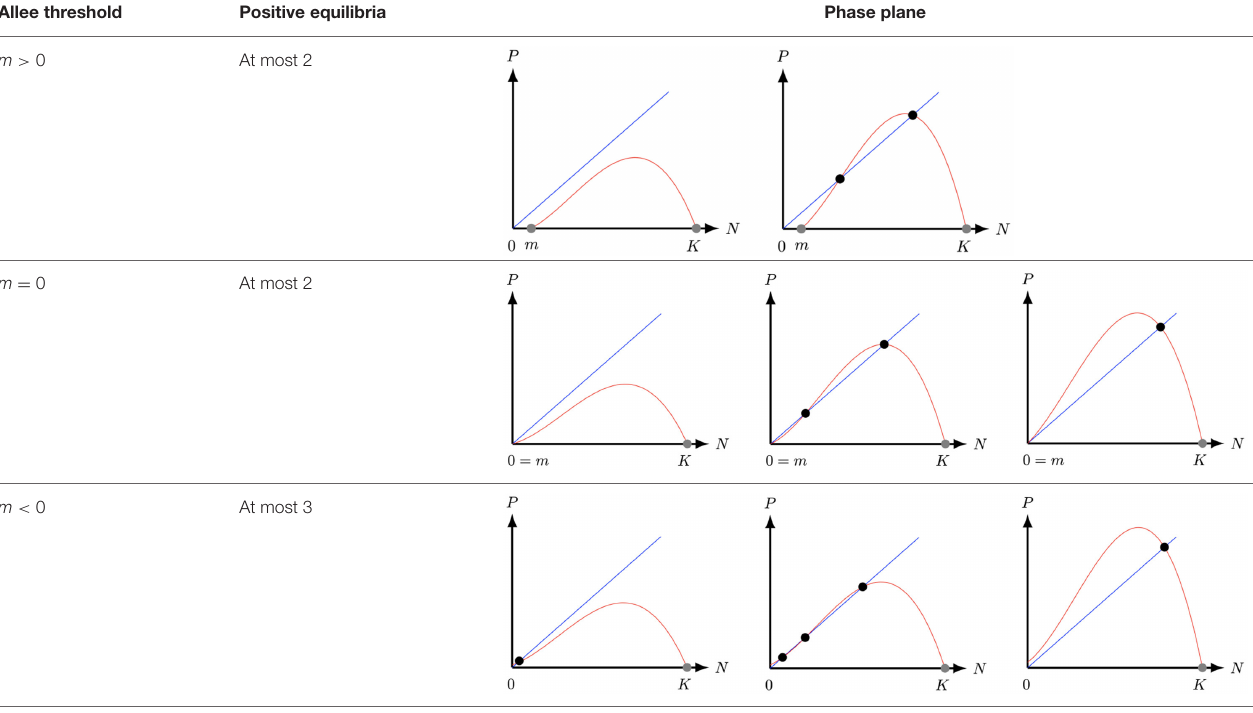
0), and weak ( m < 0) Allee effect. =